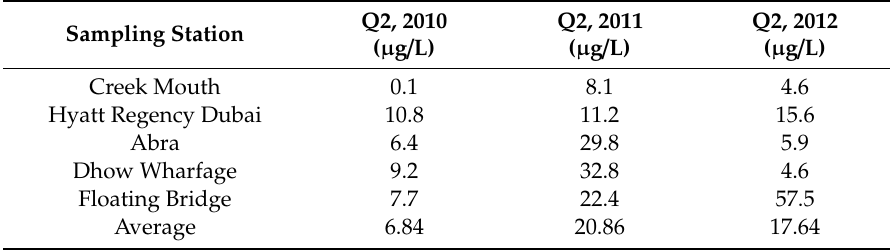
Figure 5. The correlation between in-situ measurements and the spectral reflectance of chlorophyll-a using the developed models with different band ratios based on WorldView-2 image ( A ) (CB + NIR1) / NIR2 (CI = 0.0551), ( B ) (B + NIR1) / NIR2 (CI = 0.0668), ( C ) (G + NIR1) / NIR2 (CI = 0.0717), ( D ) (Y + NIR1) / NIR2 (CI = 0.0772), ( E ) (B + NIR1) / RED (CI = 0.0980). (CI = Confidence interval). Table 4. The in-situ chlorophyll-a concentration in the second quarter of 2010, 2011 and 2012, in selected stations in the Dubai Creek.